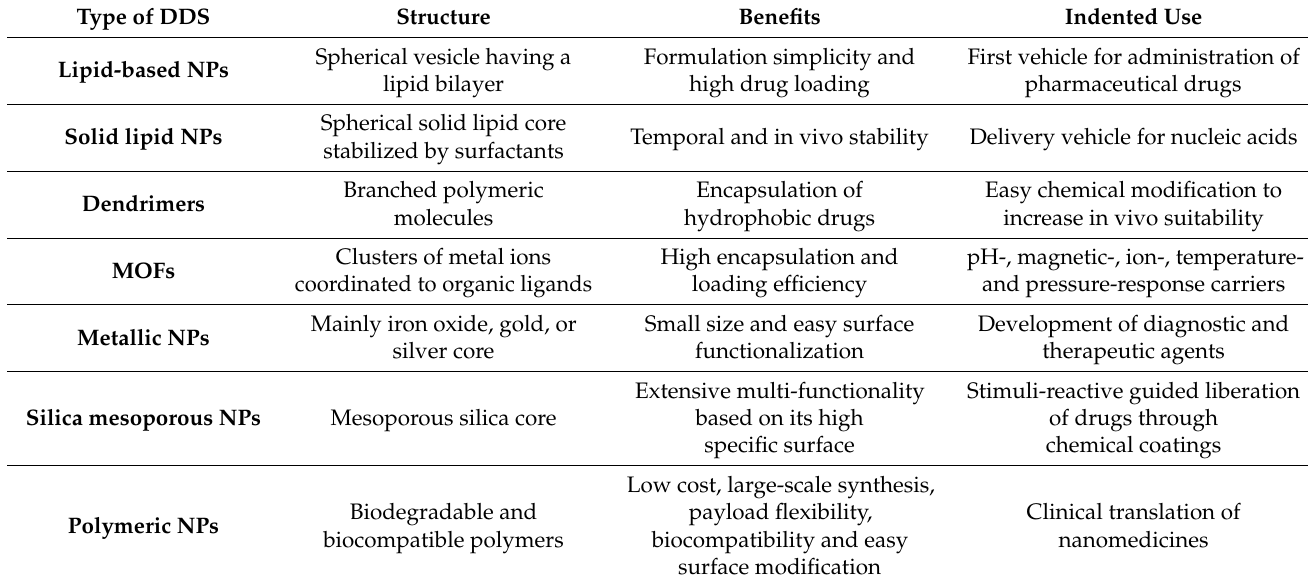
Figure 2. Advantages and disadvantages of different DDS for cancer treatment. Lipid-based NPs reach high drug loading, but their half-life in blood limits their clinical translation; solid lipid NPs fails due to low drug loading and high accumulation; dendrimers are mainly toxic and difficult to scale their synthesis; metallic NPs are easily accumulated in the body and cause aggregation phenomena; MOFs and silica mesoporous NPs are not biodegradable and toxic; polymeric NPs are the most potential candidates for clinical translation due to their high biocompatibility and payload and surface modification flexibility. Table 2. Structure, benefits and intended use of the most significant DDS in medicine.